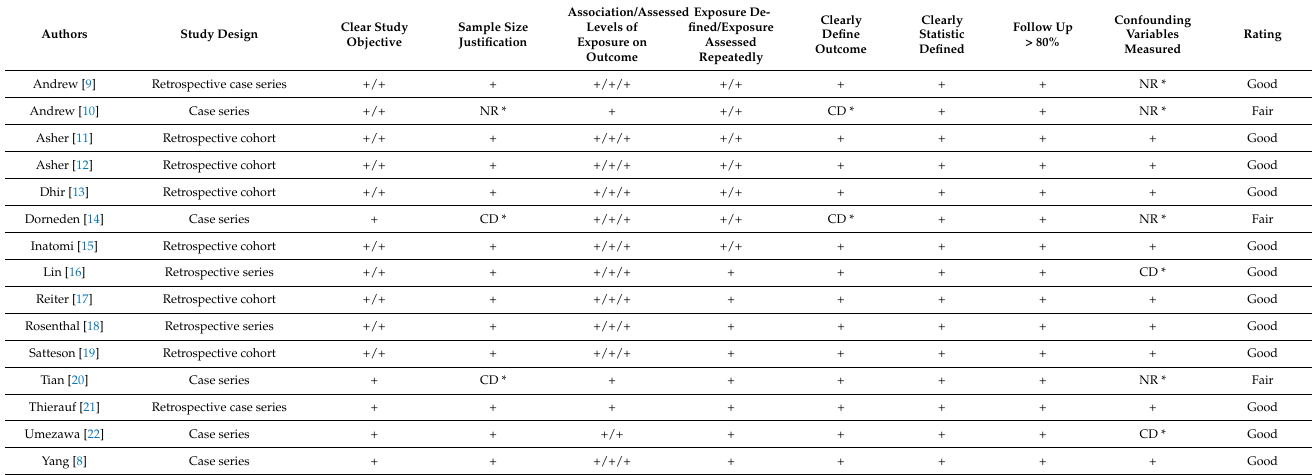
Table 3. Results of quality of assessment using National Institutes of Health Quality Assessment Tools